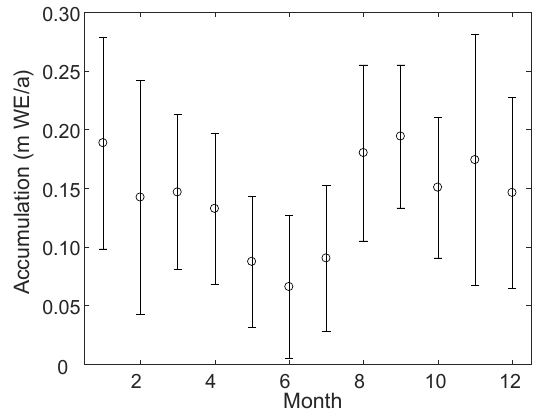
Figure 13. Plot of mean accumulation (circle) and ± 1 standard de- viation (whiskers) for each month at Summit Station,